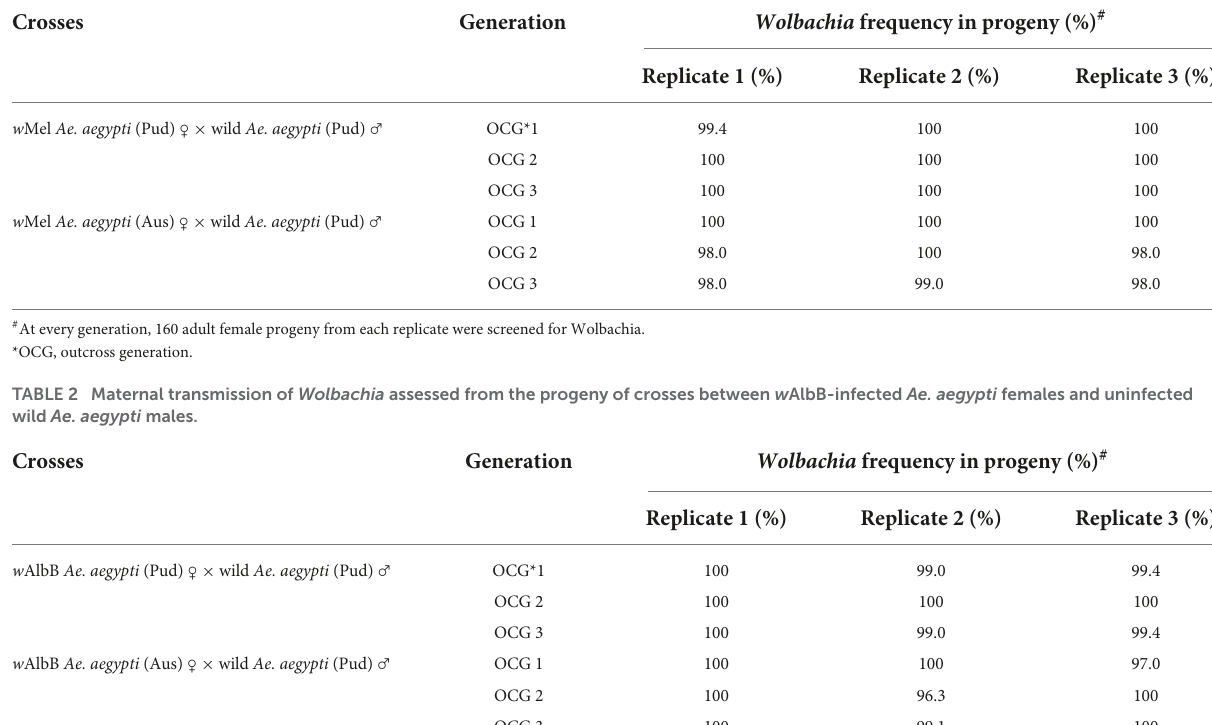
# Ateverygeneration,160adultfemaleprogenyfromeachreplicatewerescreenedforWolbachia. *OCG,outcrossgeneration.